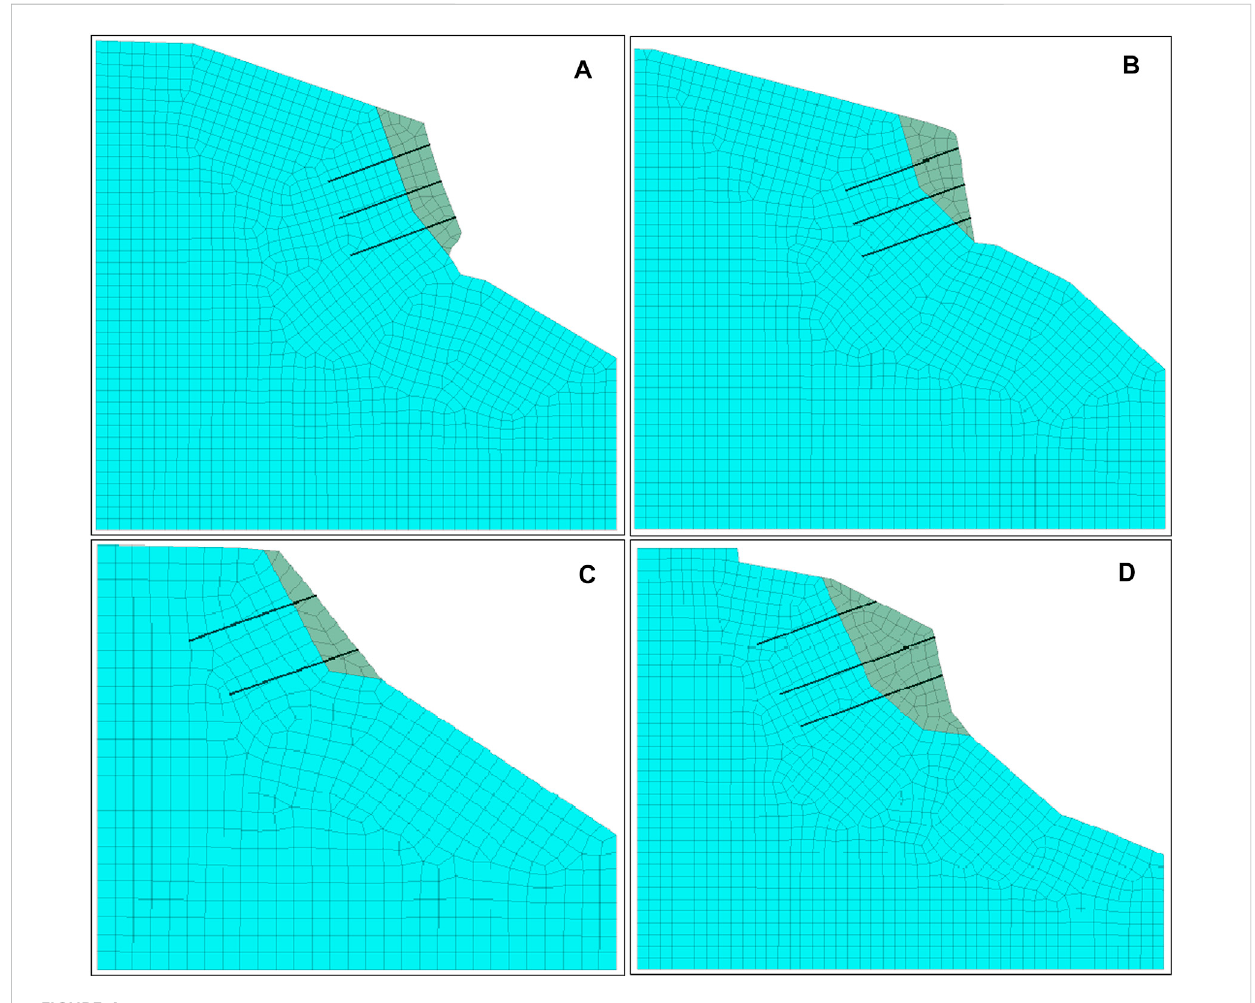
FIGURE 4 Numerical calculation models. (A) W1. (B) W2. (C) W6. (D)